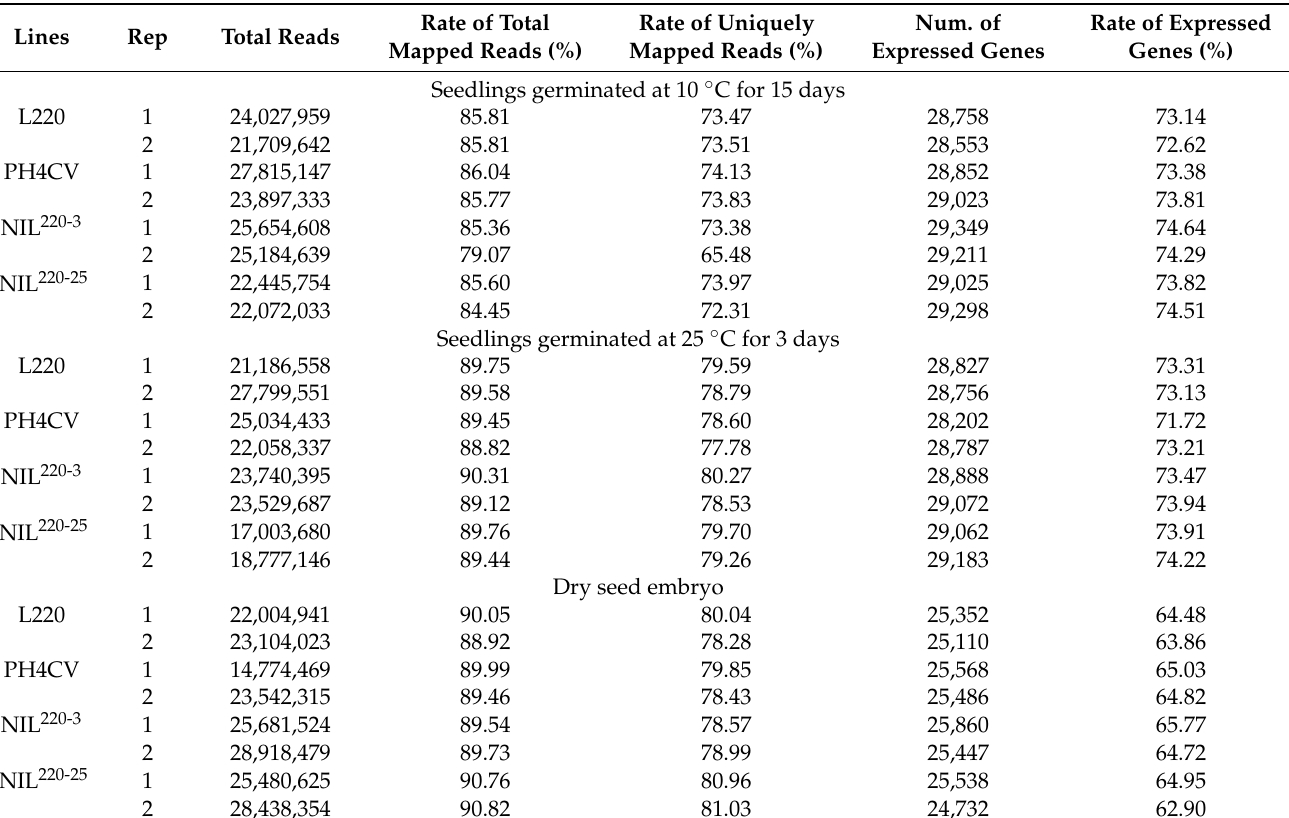
Table 1. Summary of transcriptome